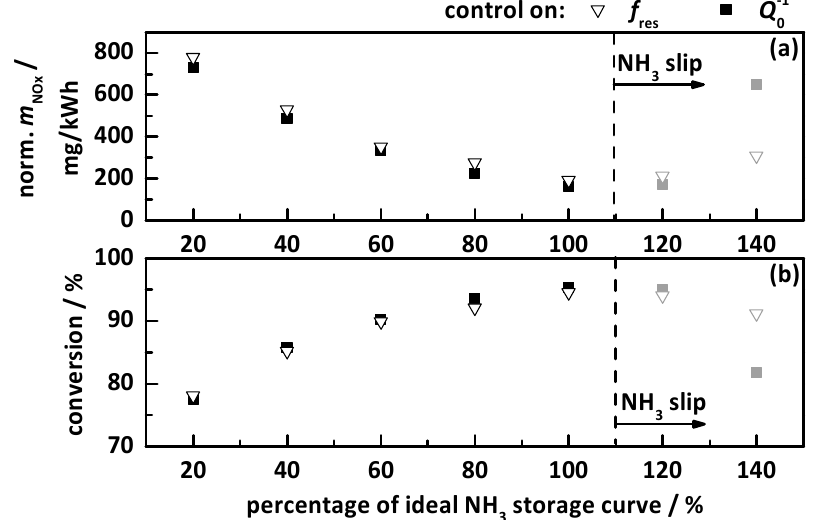
Figure 10. Results of the transient study for the control on percentage gradation of the ideal NH 3 storage curve by f res (hollow triangles) and Q 0 − 1 (filled squares), with ( a ) the apparent emitted and normalized NO x mass in mg/kWh as determined by the downstream NO x sensor, and ( b ) the resulting apparent NO x conversion within the test cycle. The storage curves right to the dashed line (grey marked) caused NH 3 slip.